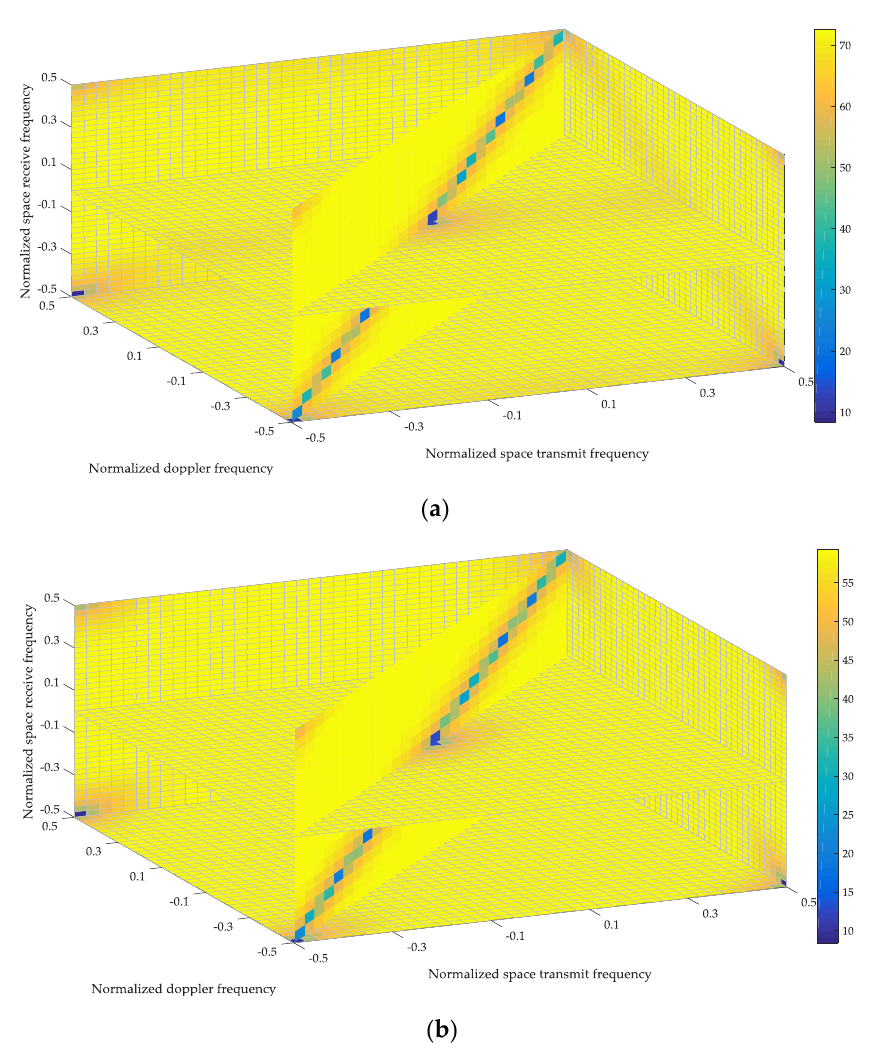
Figure 3. Variations of improvement factor (IF) with normalized frequencies. Results achieved by the proposed and conventional methods are shown in ( a ) and ( b ), respectively.